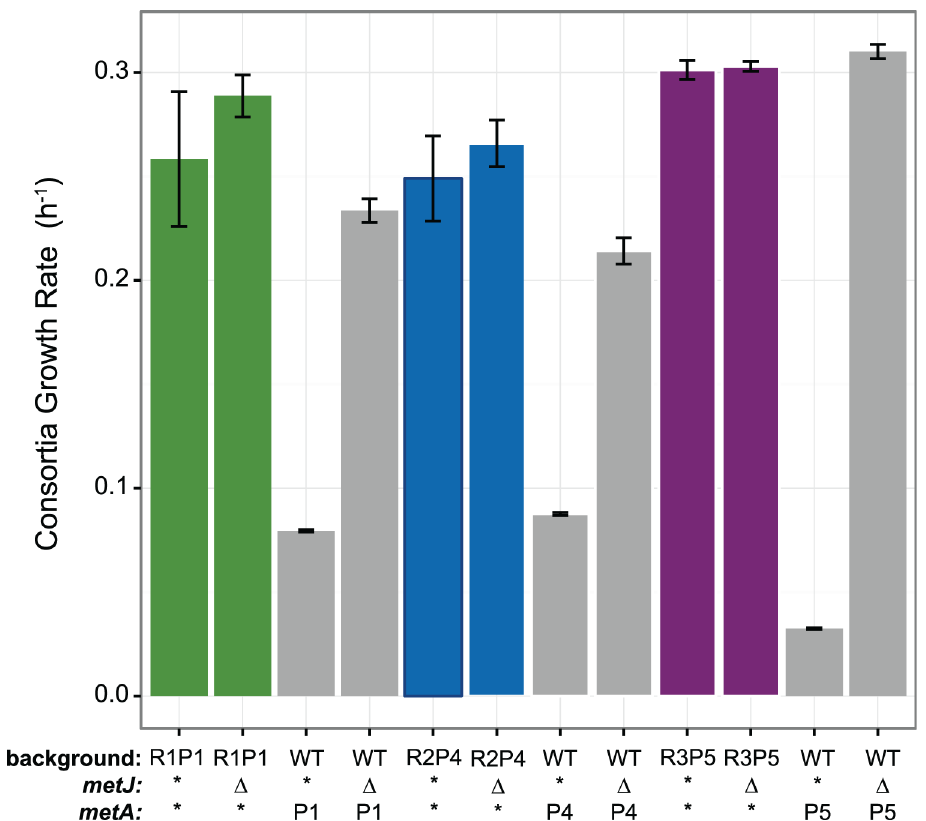
Fig 7. Null metJ mutant together with evolved metA alleles are sufficient for cooperation in wild-type S . enterica background. Asterisks indicate native allele(no substitution). Δ metJ inducedcooperation in wild- type backgrounds containing metA R1P1 , metA R2P4 , metA R3P5 . Gray indicatesreconstruction of the indicated metA or metJ allelesin the wild-typebackground, whereasthe colored bars are the RP strains isolated from selectionfor consortiagrowth, or the RP strains with a Δ metJ